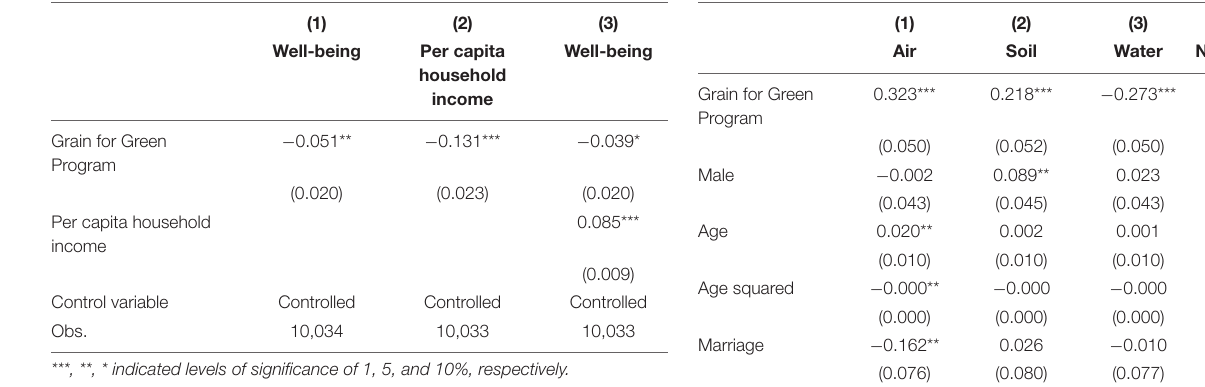
TABLE 3 | Mechanism analysis: income. TABLE 4 | Mechanism analysis: